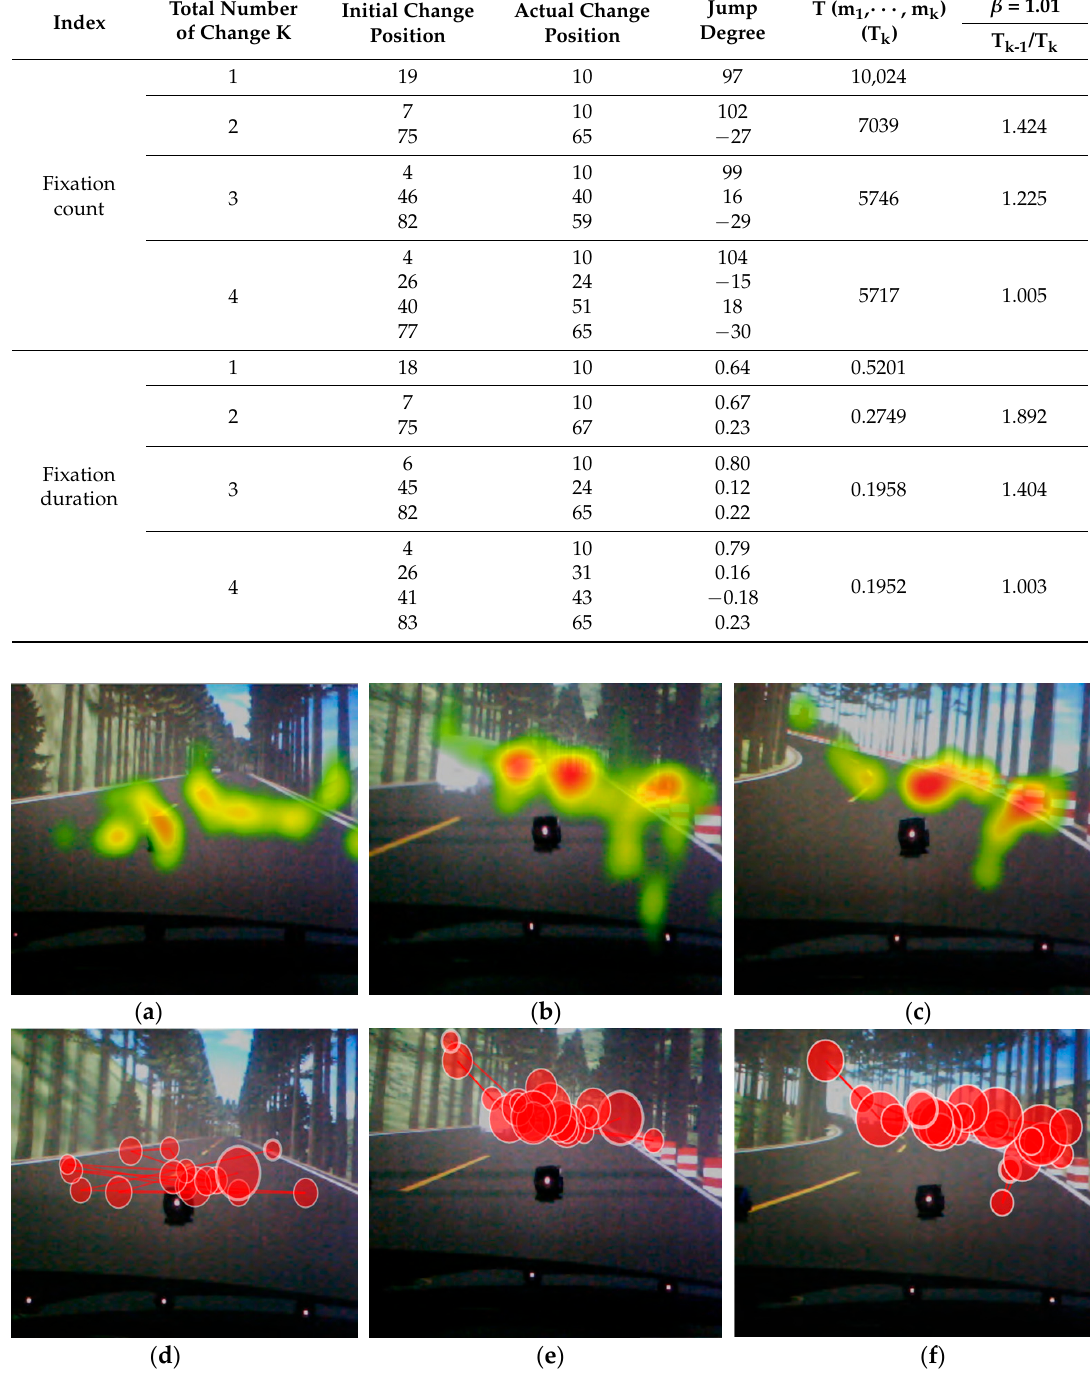
Table 6. The change-point search results by the least squares method.